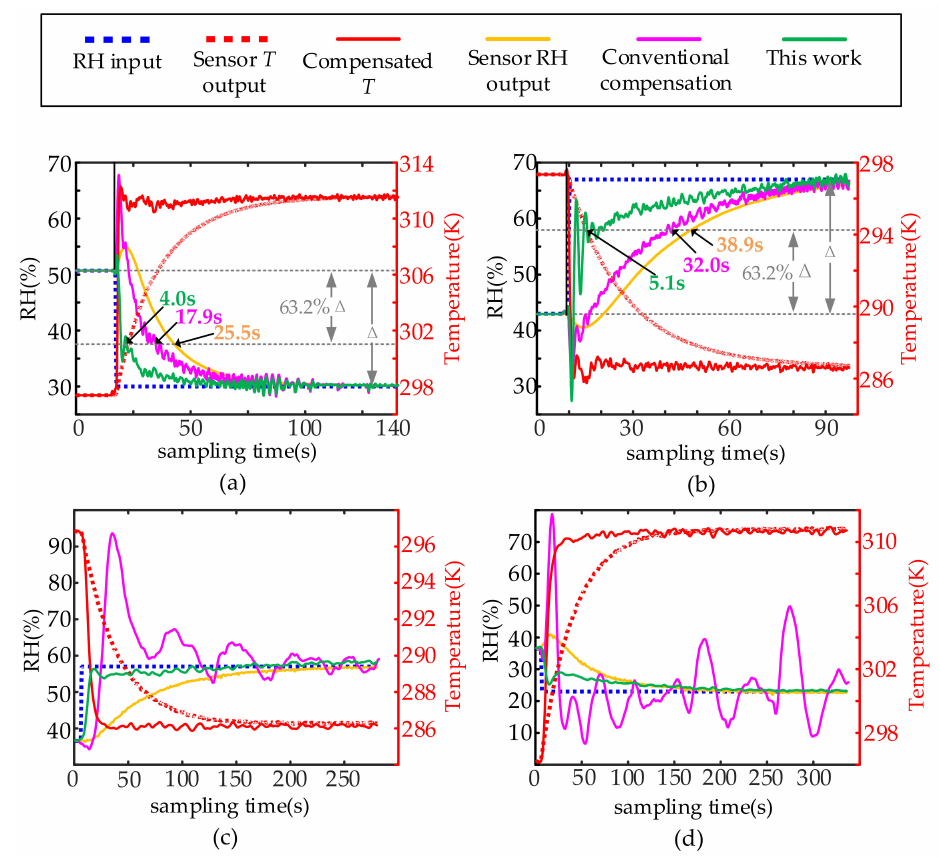
Figure 12. Experimental Compensation Results: ( a ) TI’s HDC1080 sensor, temperature and humidity switch from 50.7%RH (@ 297.35 K) to 30.0%RH (@ 311.65 K), ( b ) TI’s HDC1080 sensor, temperature and humidity switch from 43.0%RH (@ 297.35 K) to 67.0%RH (@ 286.25 K), ( c ) Sensors of our own design, temperature and humidity switch from 36.6%RH (@ 296.35 K) to 57.0%RH (@ 286.85 K), ( d ) Sensors of our own design, temperature and humidity switch from 36.5%RH (@ 296.25 K) to 23.0%RH (@ 311.15